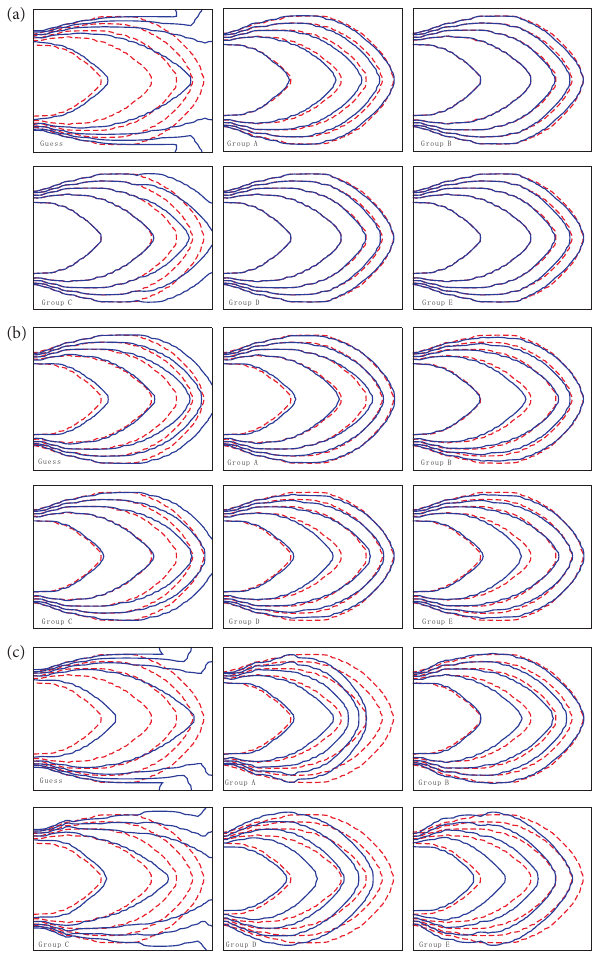
Figure 3. Comparison of the predicted and true flood extents at t = 1, 2, 3, 4, and 5s for different simulations using guessed Man- ning’s n and by assimilating the observations of group A, B, C, D, and E: (a) experiment series A; (b) experiment series B; and (c) ex- periment series C. The solid and dashed lines mark, respectively, the predicted and true flood extents.